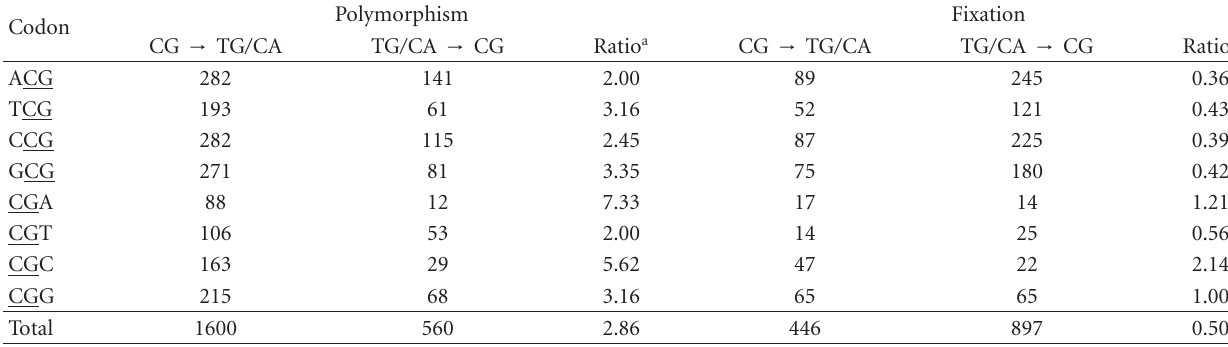
Table 2: Statistics of mutations CG ↔ TG/CA in eight CG-containing codons.